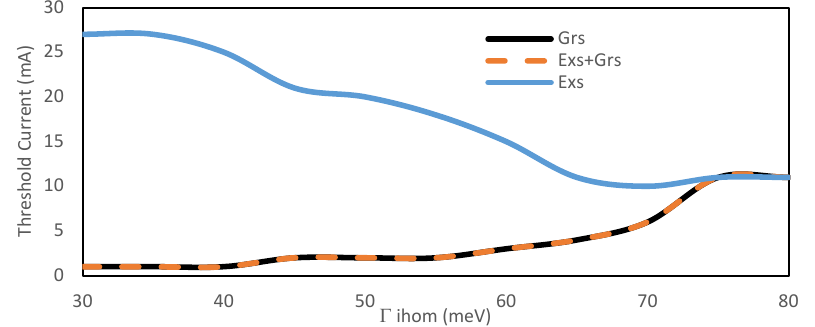
Figure 3. Variation of the threshold current as a function of Γ ihom .